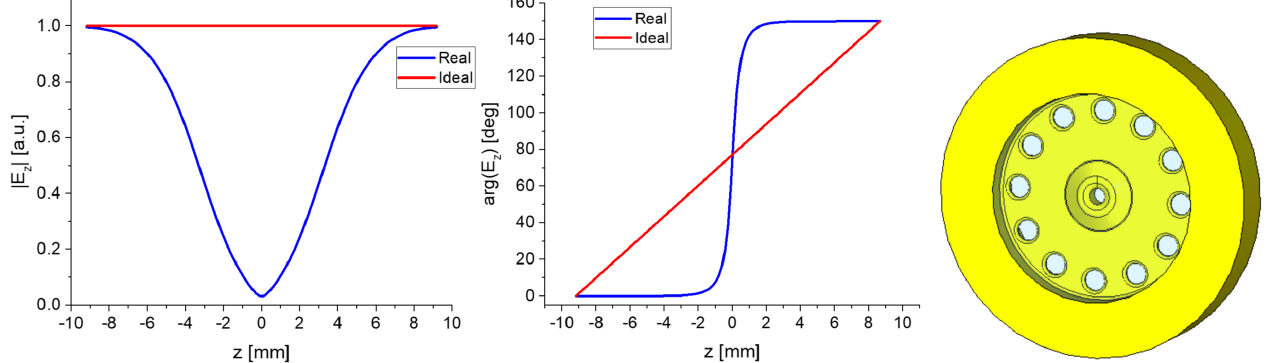
FIG. 2. Realistic (blue) and ideal (center) amplitude (left) and phase (center) distributions of traveling wave field in the middle of the β ¼ 0 . 42 5 π = 6 magnetic-coupled disk-loaded waveguide cell (right) as simulated in CST M ICROWAVE S TUDIO .